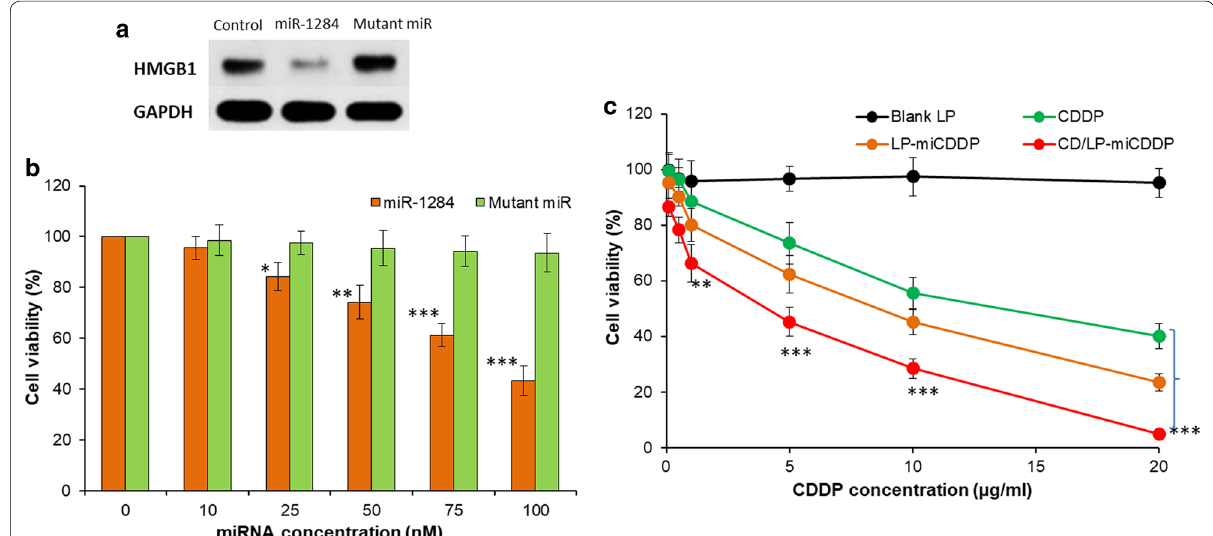
Fig. 5 a cell viability analysis of miR‑1284 and Mutant miR on the HeLa cancer cells in a dose‑dependent manner; b cell viability analysis of free CDDP and formulations on the viability of cancer cells. The cell viability was determined by MTT assay. ***p < 0.0001, CD/LP‑miCDDP and vs free CDDP